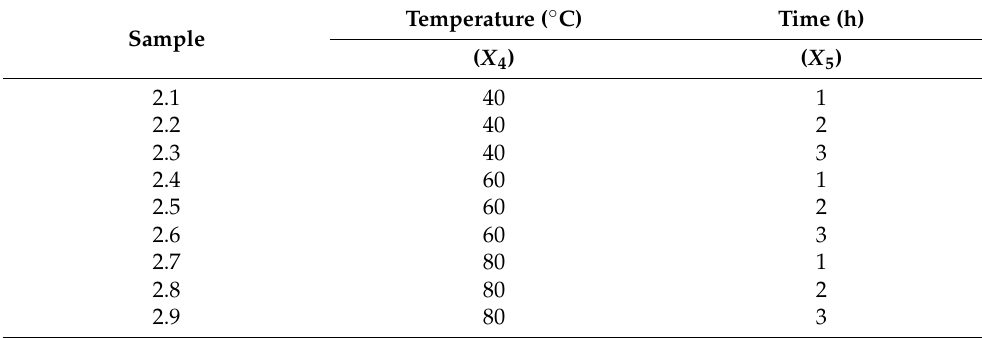
Table 2. Condition optimization for ratio optimization shown in Table 1 by the Design-Expert ® program (Stat-Ease,